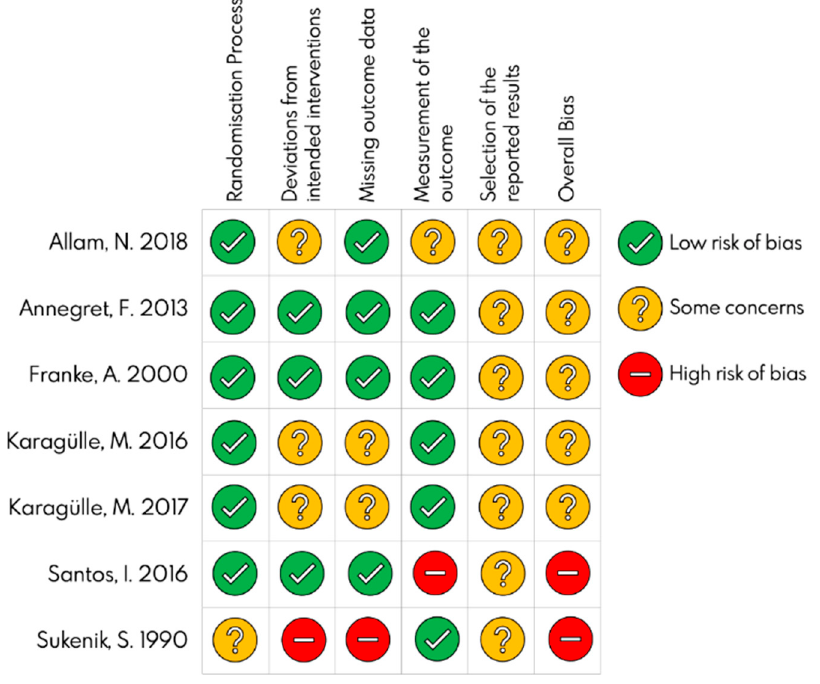
Figure 2. Individual risk of bias [24–30] .